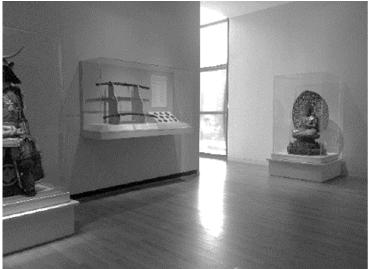
Figure 10. A view of a slim window giving a sense of orientation at UMMA.